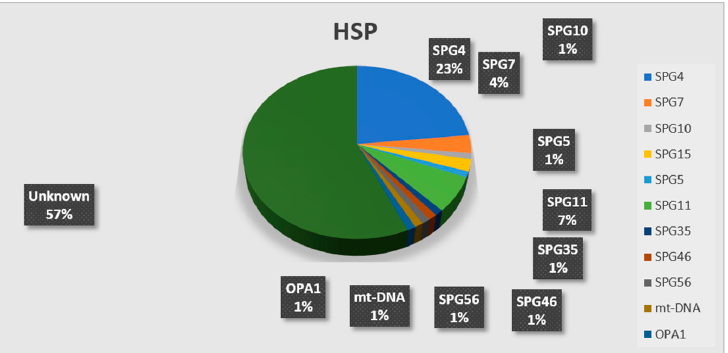
Figure 3. The pie-chart displays the results of individual gene screening in the HSP cohort, with an overall diagnostic yield of 43%. In black boxes, the relative percentages for each molecular diagnosis are reported; SPG4 was the most common HSP form, followed by SPG11 and SPG7. Regarding SCAs, a genetic diagnosis was achieved in 53/102 families (52%) (Table 1 and Figure 4). Specifically, 24/32 AD forms (75%) were polyQ SCA, with SCA2 being the most frequent (15 families), followed by SCA1 (five families), SCA3 (two families), SCA6, and SCA7 (one family each). One SCA3 patient and the SCA7 patient were not of Italian ancestry. Among the 31 ARCA families, 16 (51.6%) received a genetic diagnosis. In this case, FRDA was the most frequent etiology (10 families), followed by SACS (3 families), and one case each received a molecular diagnosis of ATM, AVED, and CANVAS. The AVED family was of Moroccan origin. Finally, 13/39 sporadic patients with ataxia (33.3%) received a genetic diagnosis as follows: four with homozygous intron 1 expansion in FXN; three biallelic variants in SPG7, 2 CANVAS, 1 SACS, 1 SCA1, 1 SCA2; and one FXTAS.